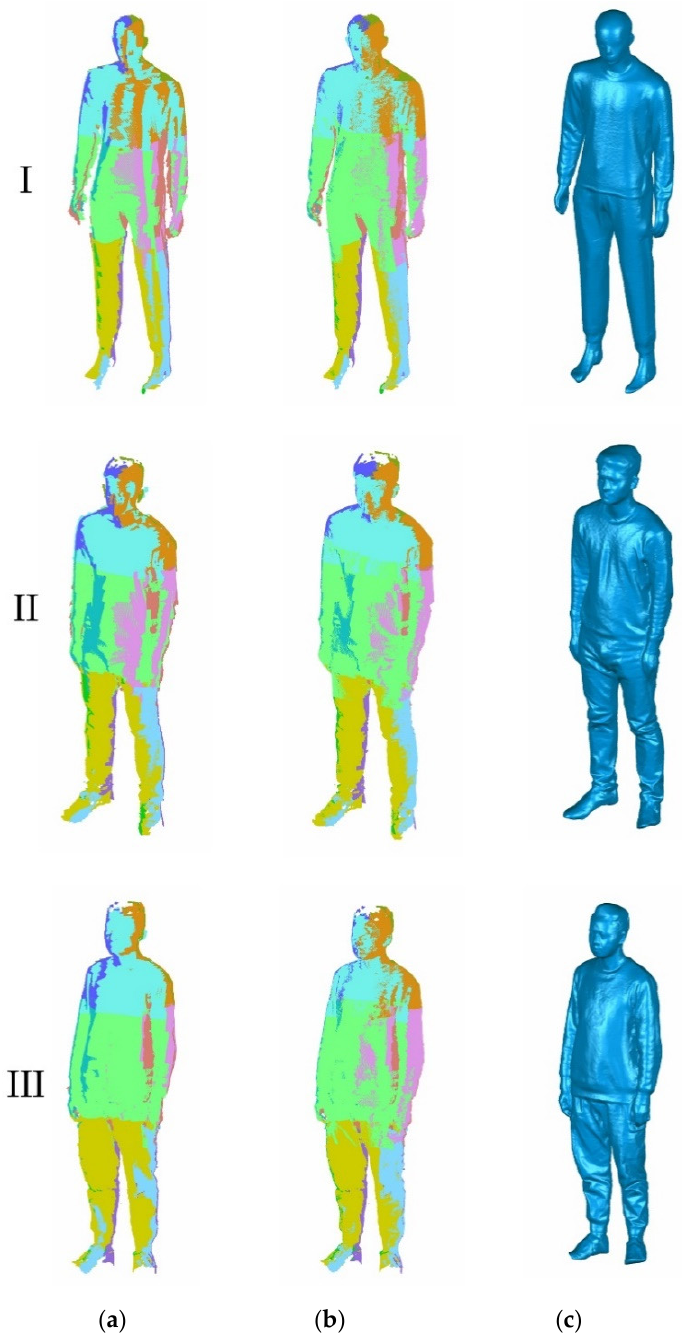
Figure 9. Human body scanning results: ( a ) point clouds of registration by system calibration; ( b ) point clouds after registration optimization; ( c ) 3D model. Table 3. Statistics for scanning time cost.